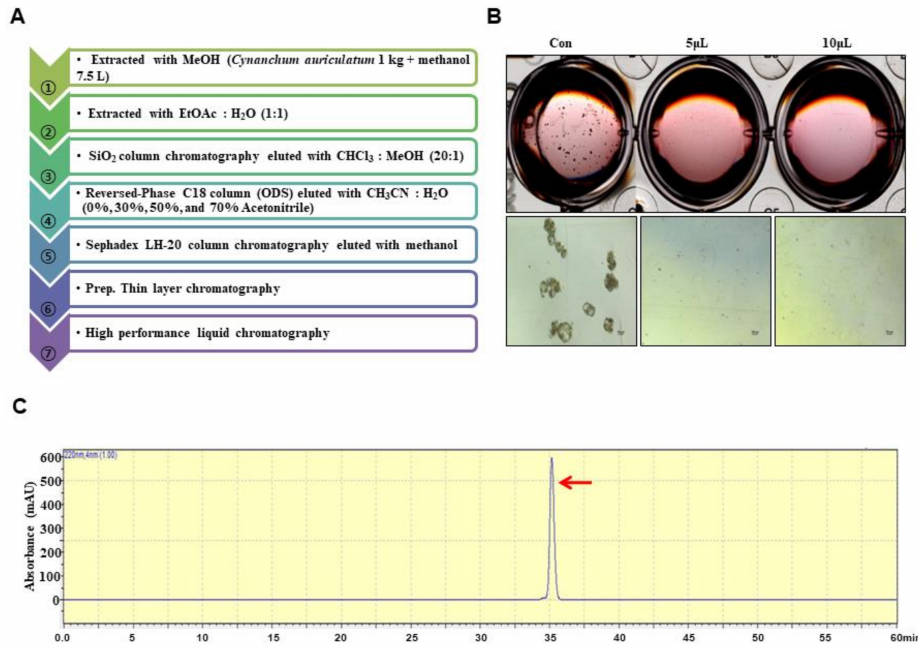
Figure 1. Purification of a cancer stem cell (CSC) inhibitor derived from Cynanchum auriculatum and assessment of extracts using a mammosphere formation assay. ( A ) Isolation procedure for the mammosphere inhibitor. ( B ) Inhibition of mammospheres using high performance liquid chromatography (HPLC)-purified samples. MDA-MB-231 cells were treated with HPLC extracts or dimethyl sulfoxide (DMSO) in CSC culture medium for 7 days. Images show representative mammospheres and were obtained by microscopy (scale bar: 100 µ m). ( C ) HPLC chromatogram of the inhibitor isolated from Cynanchum auriculatum .